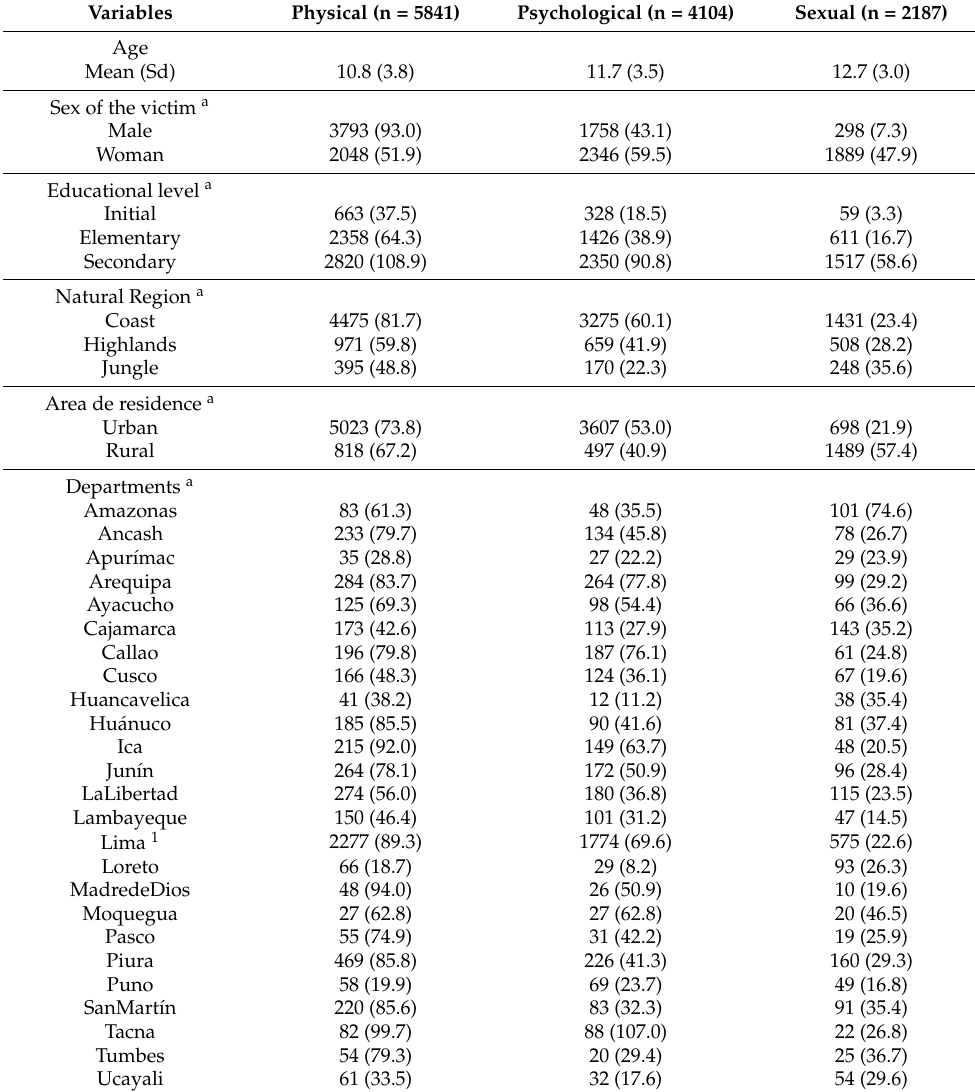
Table 1. Characteristics of the study sample according to types of